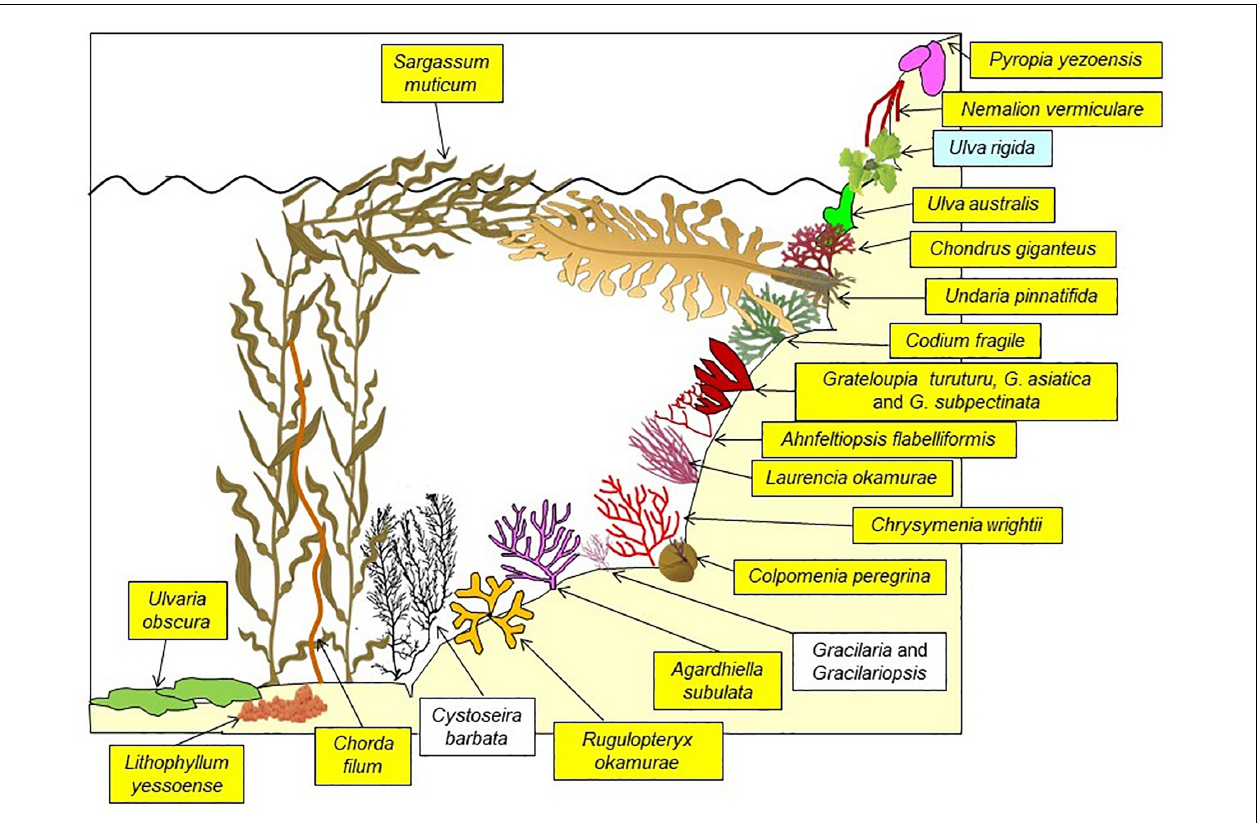
FIGURE 6 | A sketch of the dominant macrophytes on shallow (down to 1 m depth) rocky substrates of the Thau Lagoon in spring. Names on a yellow background: introduced species; blue background: probably cryptogenic introduction; white background: native species. From Boudouresque et al. (2011), modified and